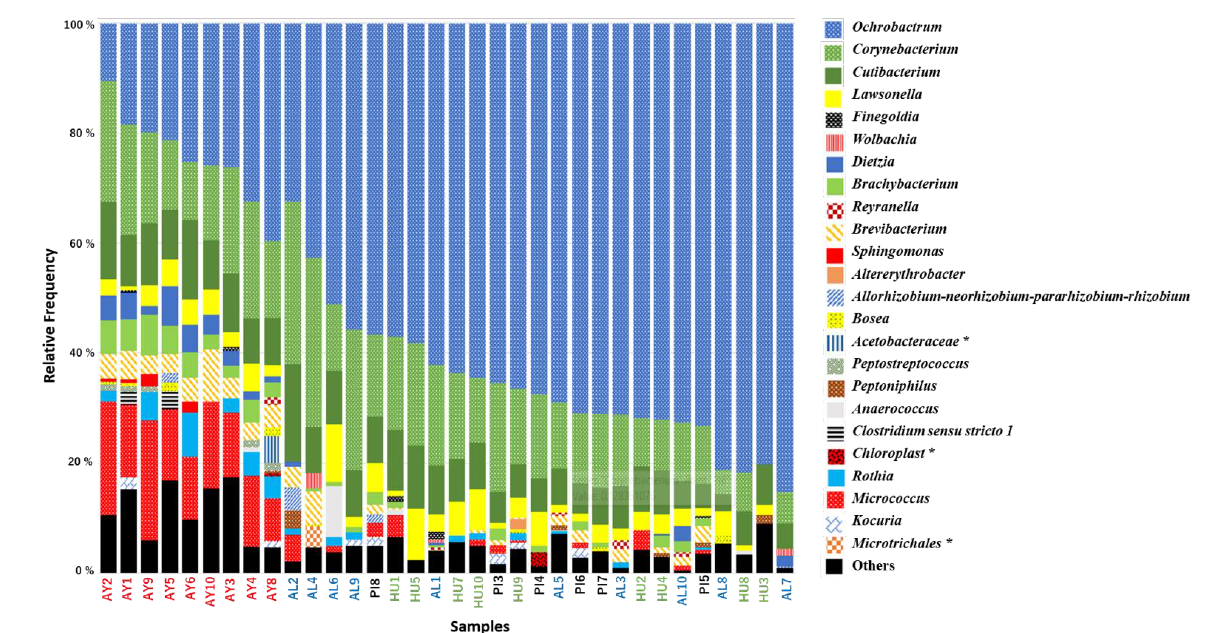
Figure 3. The bacterial genus composition of different Lutzomyia ayacuchensis populations. Ecuador (AL, Alausi; HU, Huigra); northern Peru (PI, Piura); southern Peru (AY, Ayacucho). The asterisk indicates other-level classifications when Qiime2 failed to provide the genus level.